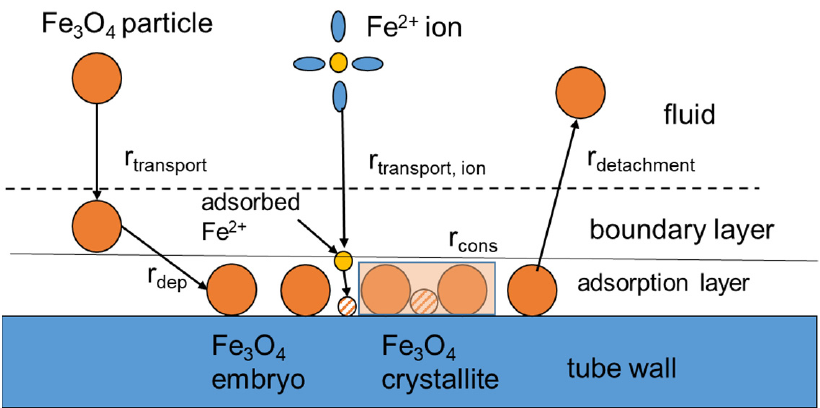
Figure 1. A simplified scheme of the proposed model. This model deals with the specific case in which an energy barrier occurs due to the presence of electrostatic repulsion between colloidal particles and the surface of the tube material. Since such interactions occur at very small distances compared to the thickness of the diffusion layer, the surface boundary layer approximation (SFBLA) [14] is applied. In turn, consolidation of the particles is assumed to be the result of crystallization of a magnetite-type oxide, which has the ability to bind individual magnetite particles together, preventing their detachment from the surface. Several authors [15–18] suggest that the crystallization of magnetite is governed by the mechanism of Johnson–Mehl–Kolmogorov– Avrami (JMKA) for simultaneous nucleation and growth [19]. It is assumed that the rate-determining stage of the process is dehydration of Fe(OH) 2 , which is the main soluble form of Fe in slightly alkaline high-temperature, high-pressure electrolytes, such as the secondary coolant of nuclear